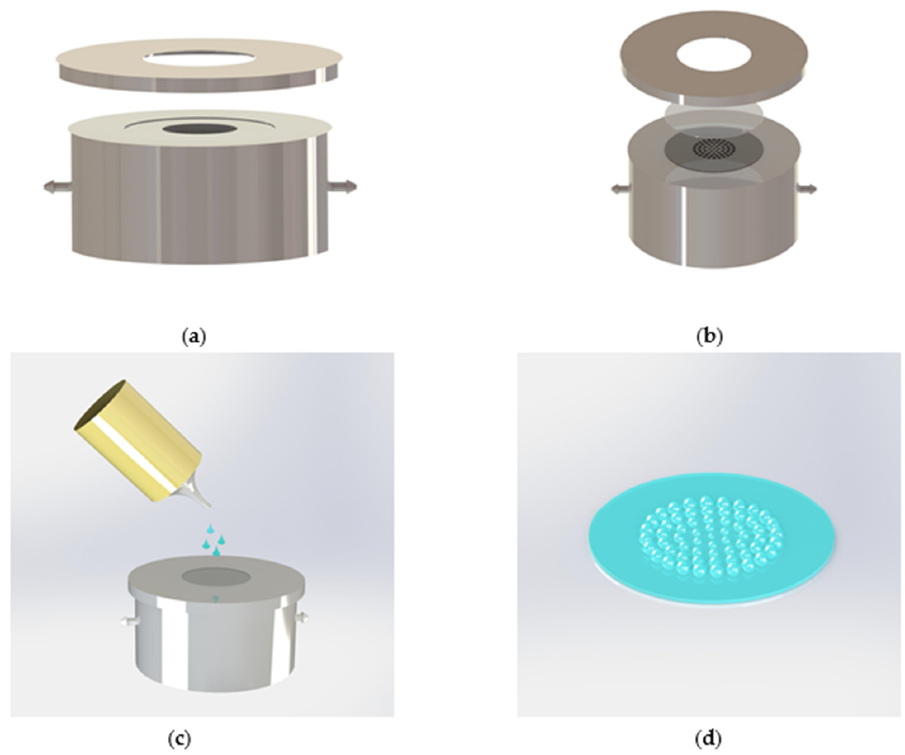
Figure 5. Fabrication of the planar microlens array (MLA). ( a ) The homebuilt gas-assisted mold to fabricate the planar MLA; ( b ) the PDMS film and the silicon wafer with MLAs are placed in the mold; ( c ) the UV adhesive (NOA 63) is dropped under negative pressure; ( d ) the fabricated planar MLA. After obtaining the planar MLA, it is fixed in the prepared PMMA mold, as shown in Figure 6. The PDMS droplets are dropped into the mold and placed in a 60 ◦ C environment for thermal curing for 12 h. After the PDMS solution curing, a thin replicated film with a reversed MLA of the planar MLA can be achieved.